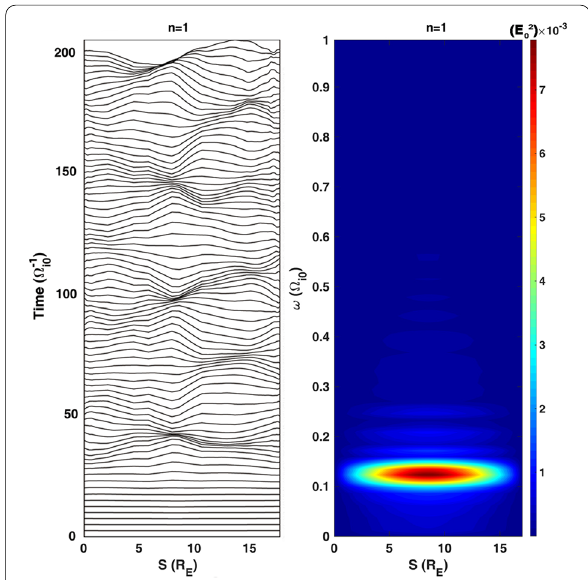
Fig. 13 Case II: fundamental harmonic components of E r along the closed field line in the noon-meridian plane at L eigenstructure oscillations of fundamental harmonic of E r between t 50 200 (cid:31) − 1 i 0 in time sequence. Right: the wave power spectra of = − the fundamental harmonic of E r by using plane wave analysis